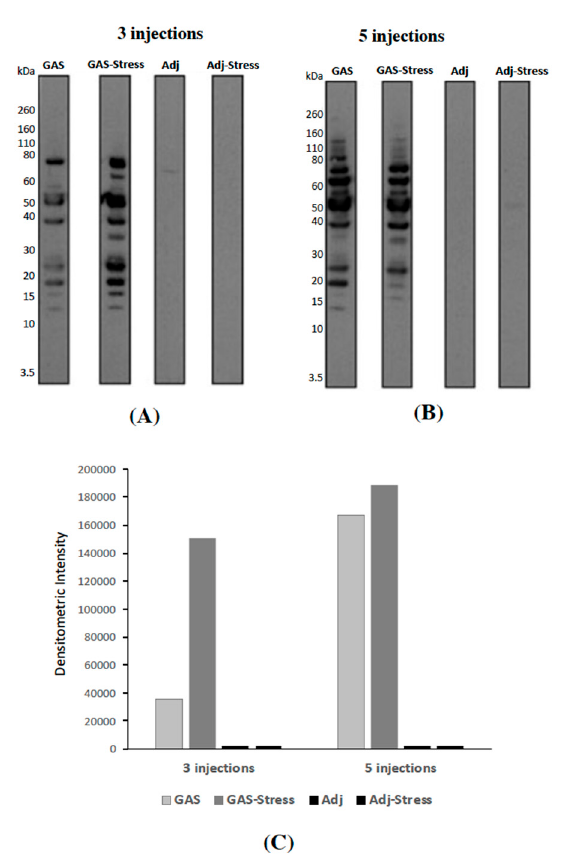
Figure 2. ( A , B ): Representative immunoblot of GAS extracts probed with pooled sera from mice either treated with 3 ( A ) or 5 doses ( B ) of GAS homogenate (GAS), GAS homogenate and psychosocial stress (GAS-Stress), adjuvant alone (Adj), or adjuvant and psychosocial stress (Adj-Stress). ( C ): Densitometric analysis of overall lane intensities from the blot shown in A , B .